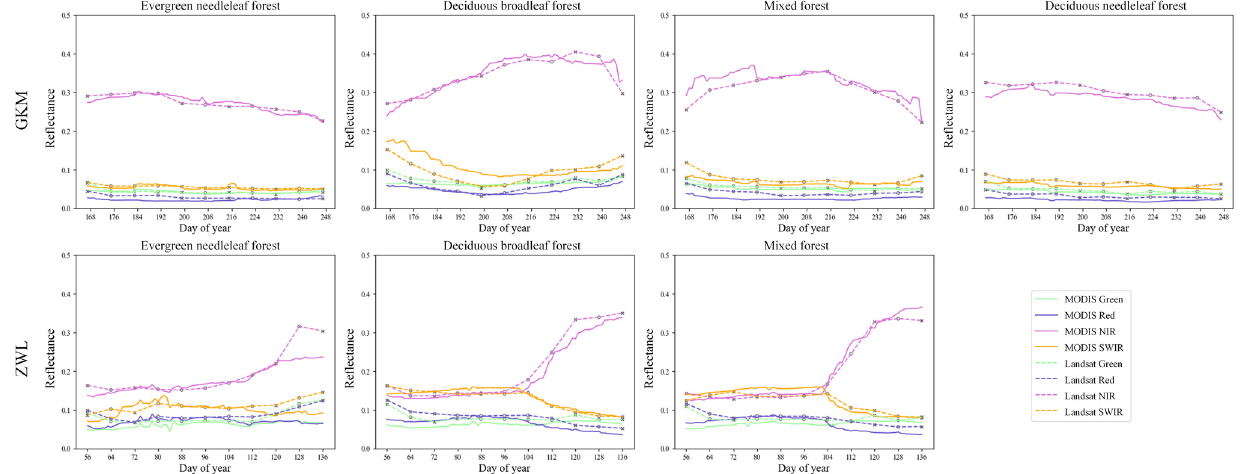
Figure 12. MODIS and Landsat reflectance time series of different forest types in GKM and ZWL regions. The top row represented the temporal trajectories of reflectance in GKM, and the bottom row corresponded to temporal trajectories of reflectance in ZWL.